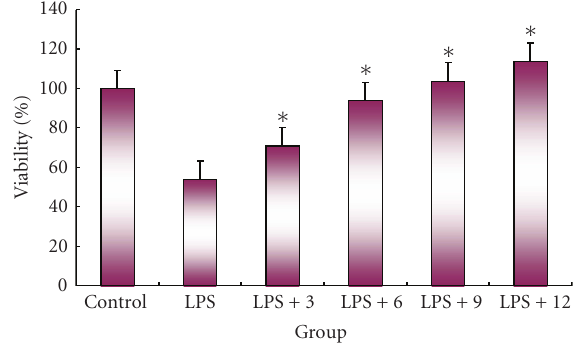
Figure 3: Changes of the cell viability in RAW264.7 cell by MTT. Control = 0LPS, LPS = 1 μ g LPS, LPS + 3 = 3mg LPS, LPS + 6 = 6mg LPS, LPS + 9 = 9mg LPS, LPS + 12 = 12mg LPS.